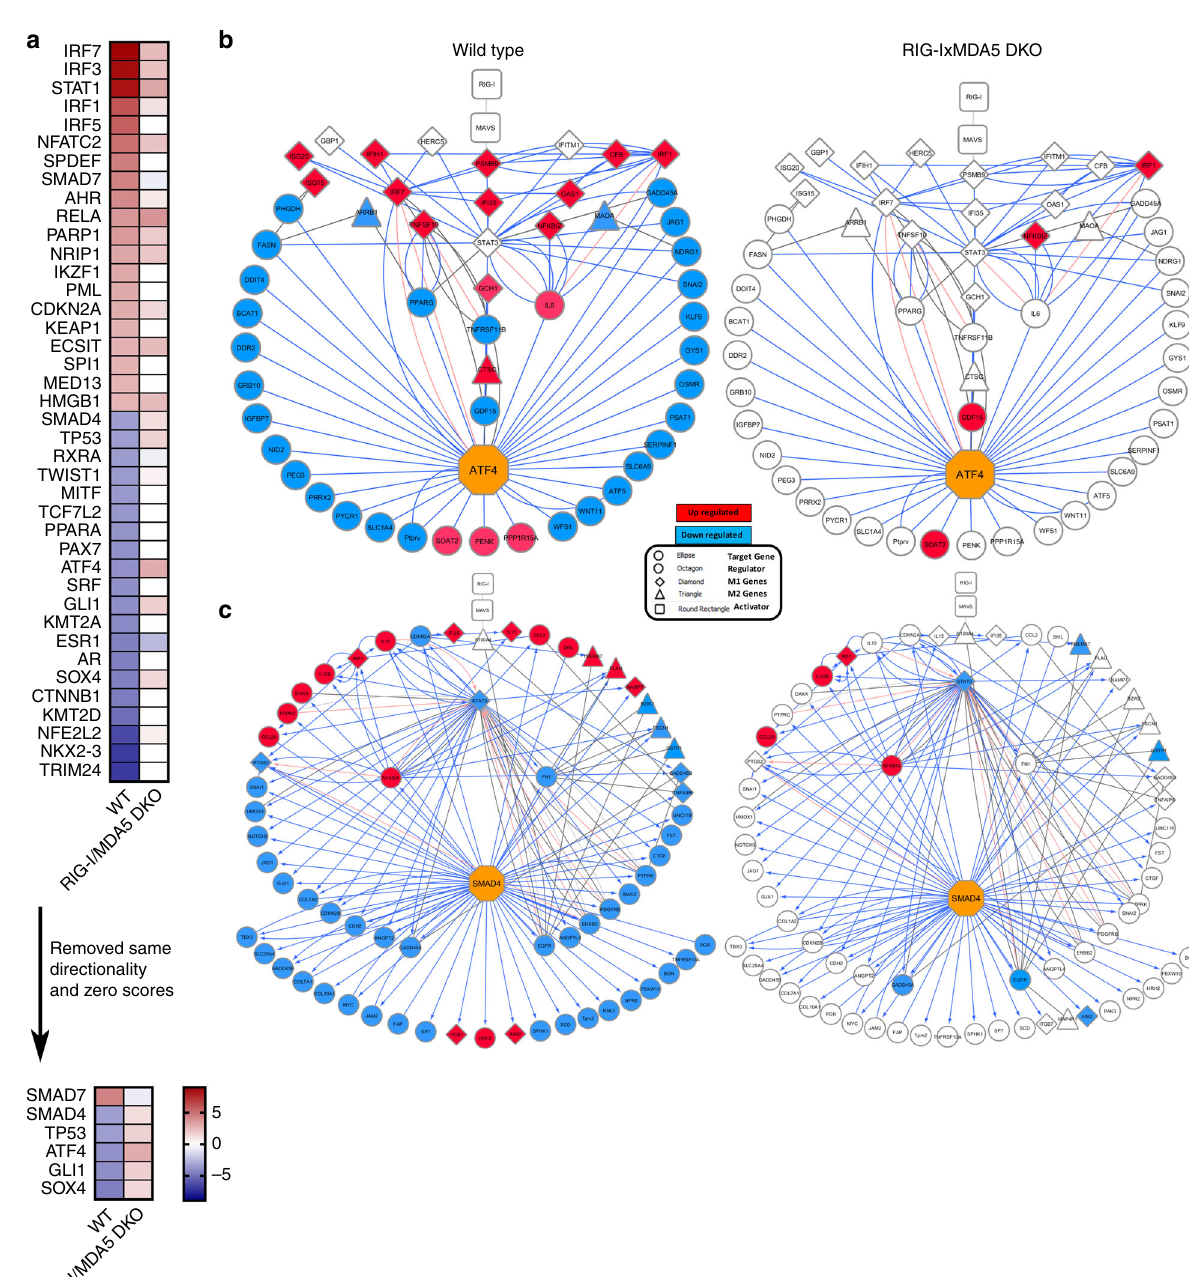
Fig. 7 ATF4 and SMAD4 are potential mediators of the RLR-based macrophage response to WNV. a Upstream regulator analysis predicted regulators (Z-scores) are shown by heatmap where red shows predicted activation and blue shows predicted inhibition. This analysis was fi ltered to remove all regulators that had the same directionality in WT and DKO data sets as well as any regulator that had a zero Z-score in either dataset (bottom). b , c Network analysis of ATF4 target genes ( b ), SMAD4 target genes ( c ) and M1/M2 signature genes (both) in the WT response (left) and the DKO response (right). Predicted upstream transcriptional regulators are noted as orange octagons with the remaining nodes in our network are labeled by gene name. In the networks, shapes indicate gene category (circles — transcription factor target gene, octagon — regulator of interest, diamonds — M1 genes, triangles — M2 genes, and squares — activators). The colors are the directionality of the gene in our dataset (red is induced, blue is suppressed, and white is not changed compared to mock). n = 3 independent infections, RNA preparations, and sequencing results. Source data are provided as a Source Data fi